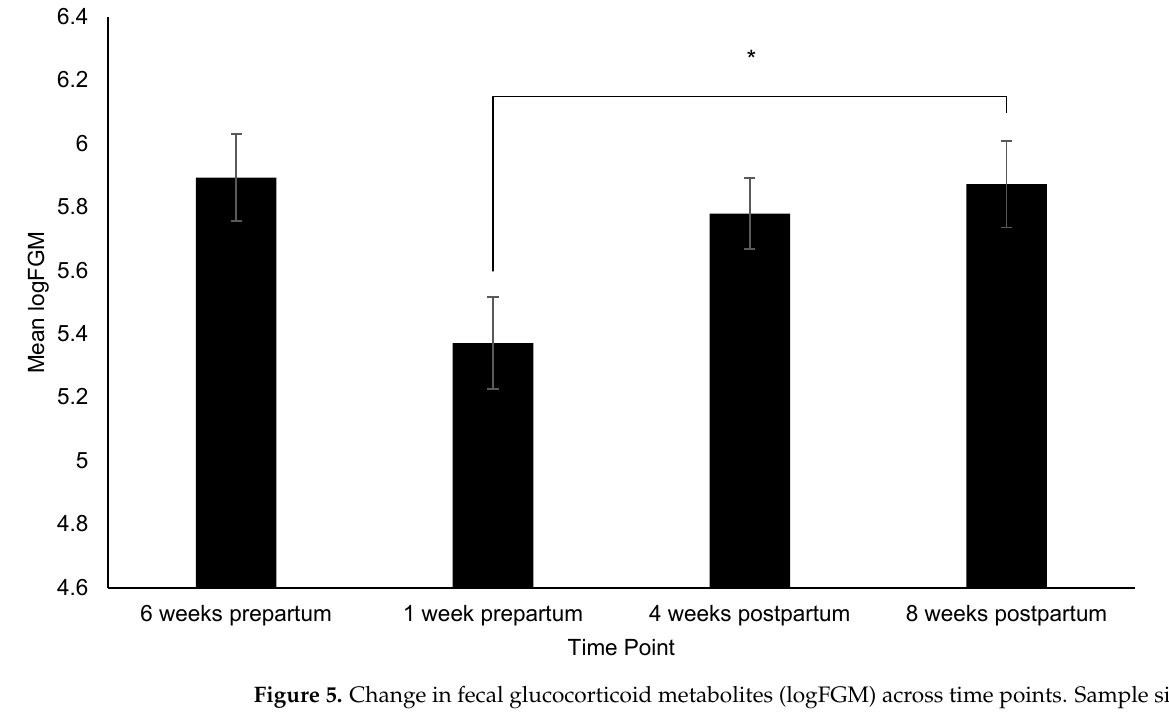
Figure 5. Change in fecal glucocorticoid metabolites (logFGM) across time points. Sample sizes for each time point were n = 34, n = 37, n = 53, and n = 52, respectively. Error bars represent SE. * indicates p ≤ 0.05.